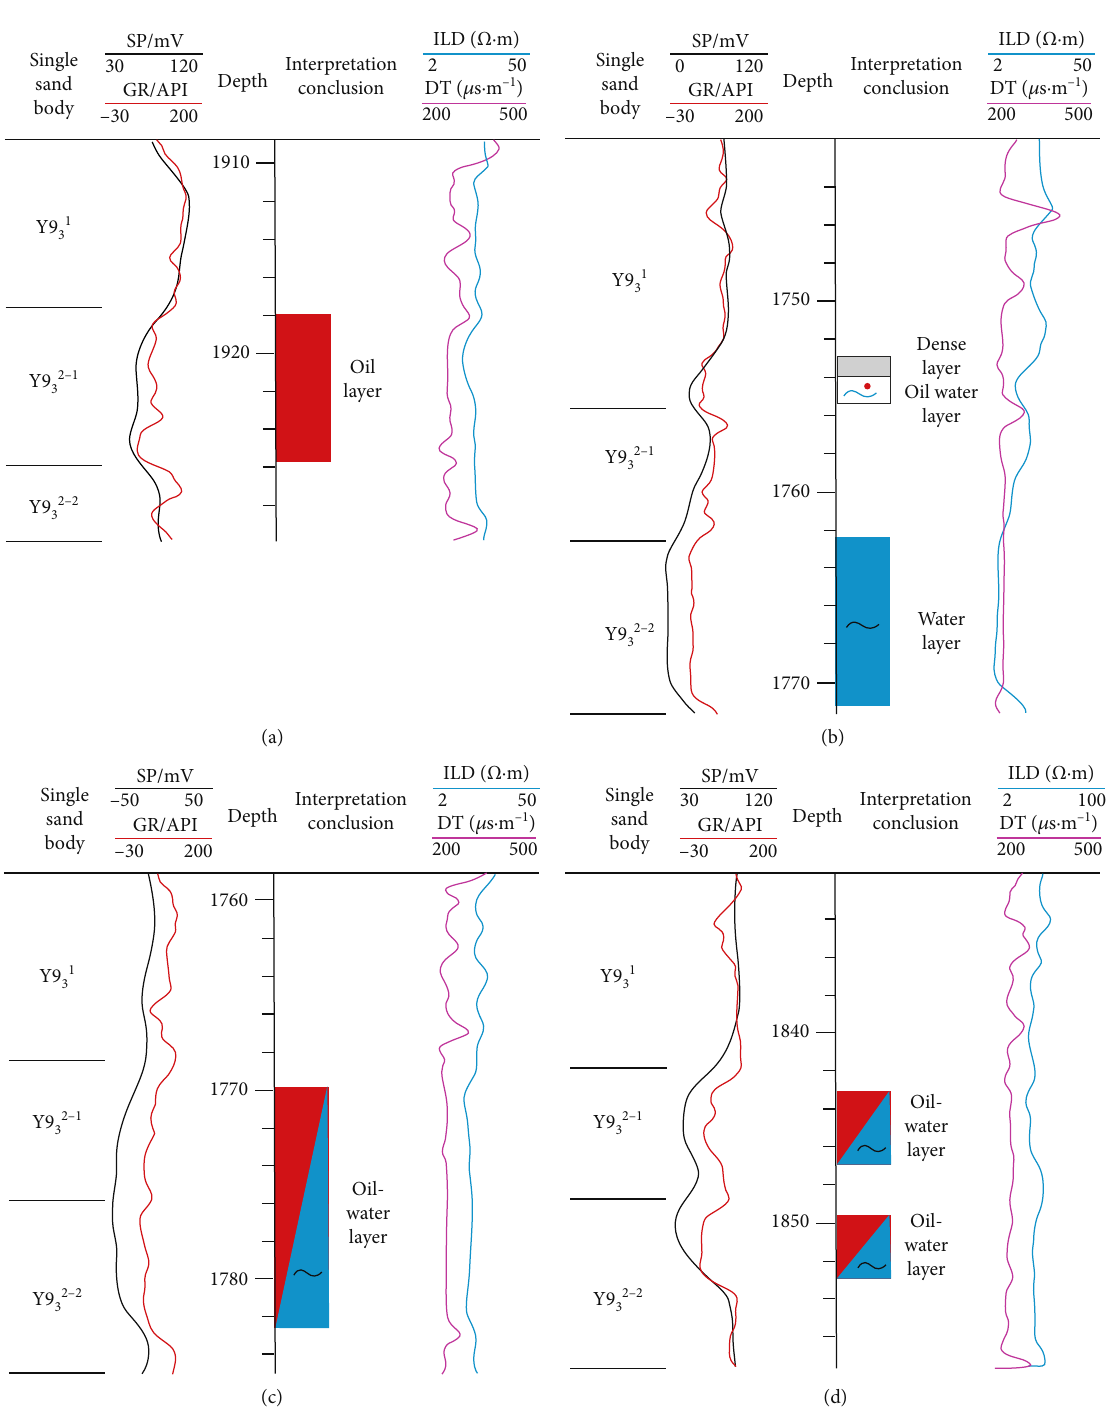
Figure 12: Con fi guration mode of single sand body superposition in Yan 9 32